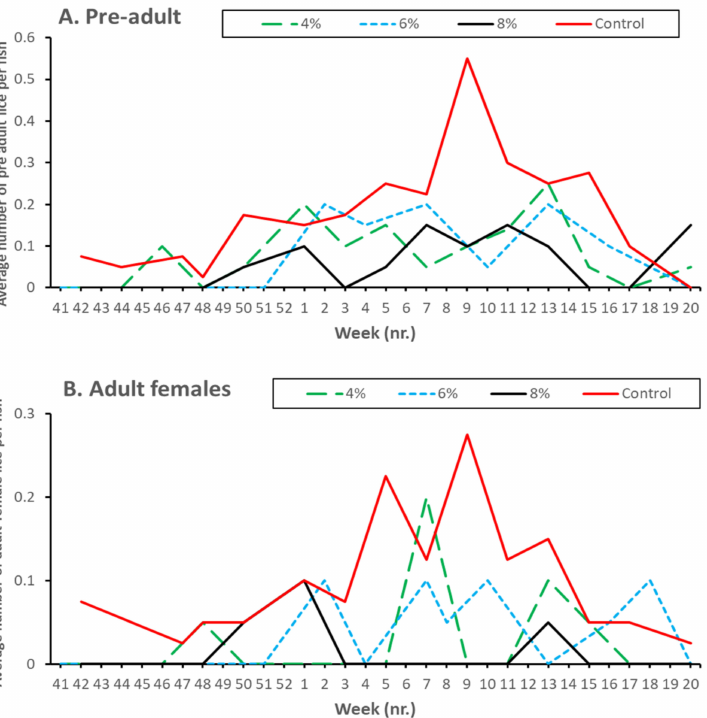
Figure 4. Occurrence of pre-adult ( A ) and adult female ( B ) L. salmonis on Atlantic salmon in large- scale sea cages at Lerøy Aurora, northern Norway, with 0 (control), 4, 6, and 8% density of lumpfish recorded for duplicate treatments during biweekly sampling. Figure modified from